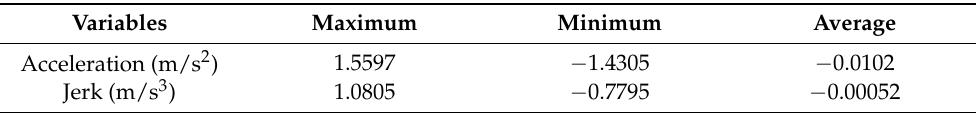
Table 4. Statistics of the acceleration and jerk of the host vehicle without cut-in recognition under driving scenario